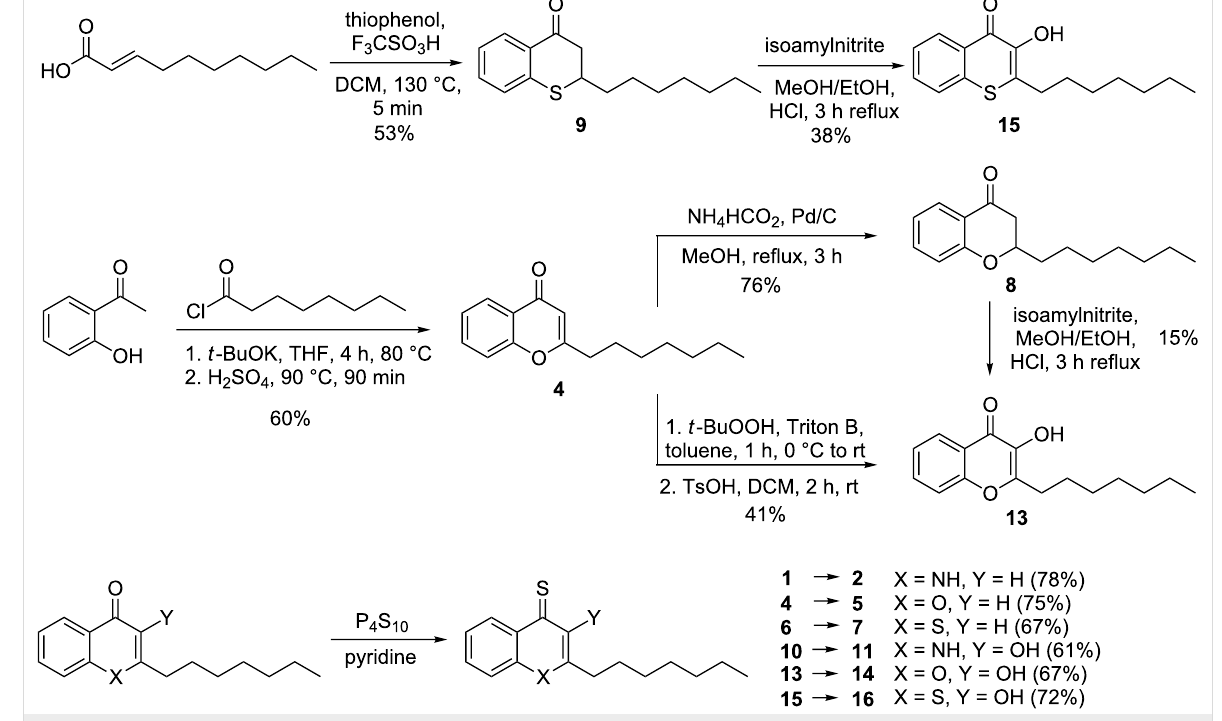
screening experiment indicates a potential hit